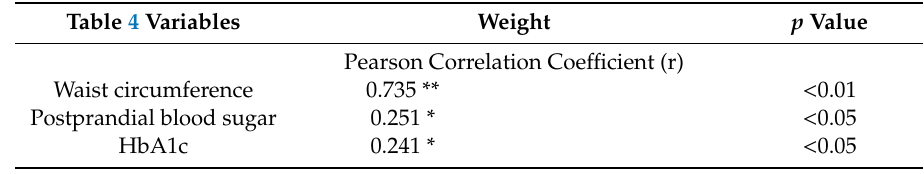
Table 6. Correlation between weight and other study variables after 24 weeks of diet intervention. Table 4 Variables